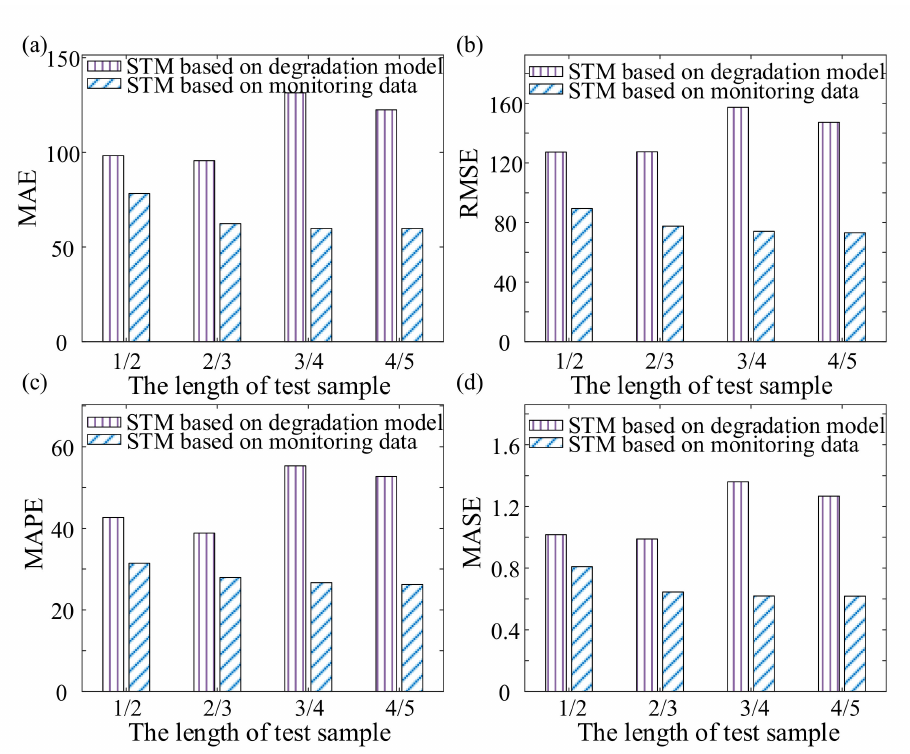
Figure 7. MAE, RMSE, MAPE, and MASE results of Set #4 based on the different test